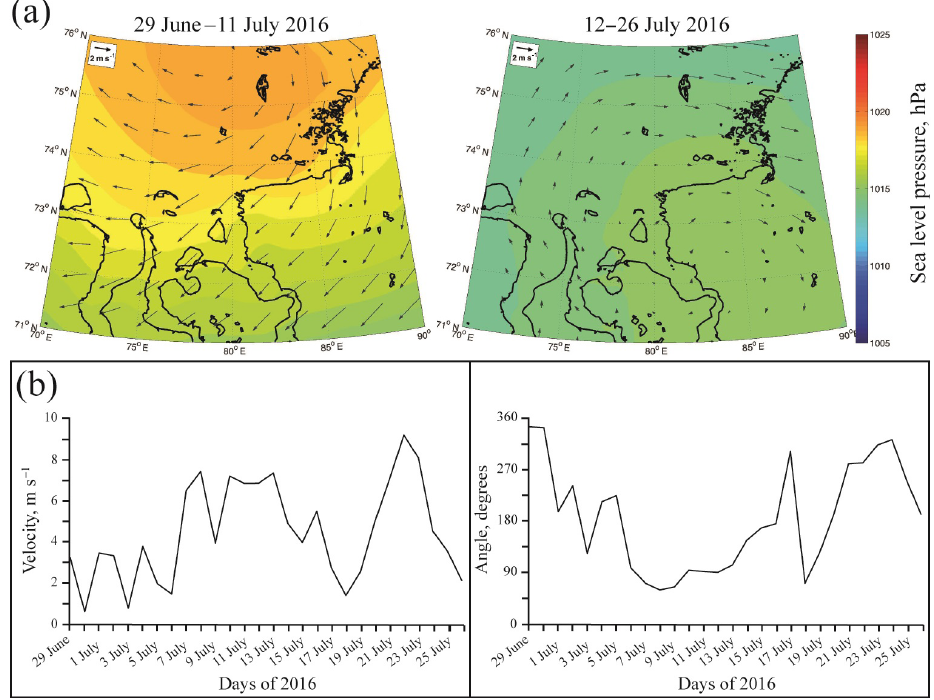
Figure 3. Average wind forcing (arrows) and sea level pressure (color) during 29 June–11 July (left) and 12–26 July 2016 (right) in the central part of the Kara Sea (a) . Daily average wind speed (left) and direction (right) during 29 June–26 July 2016 (b) . Wind data were obtained from the ERA5 atmospheric